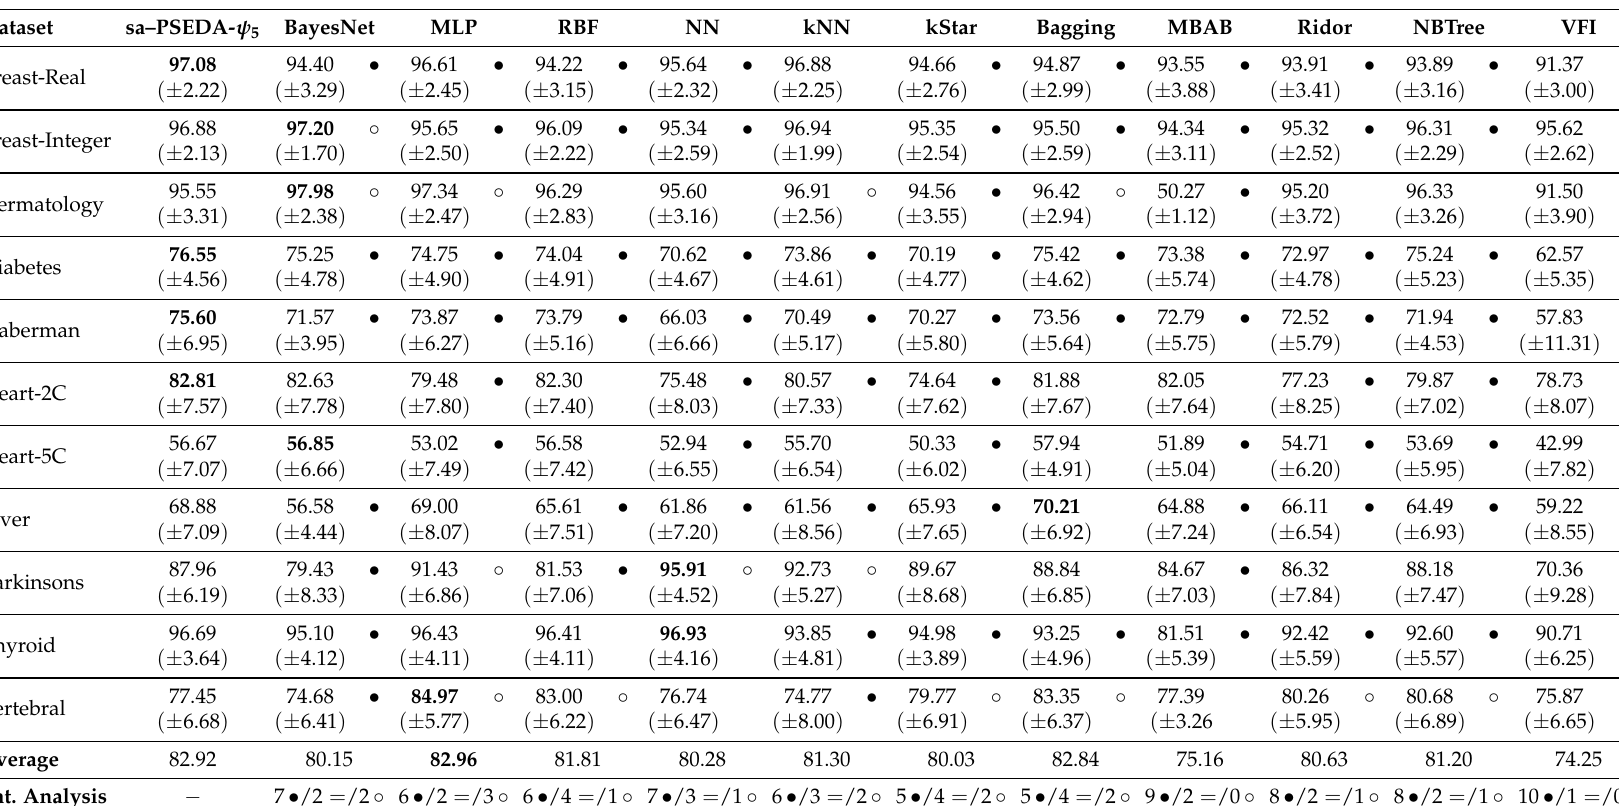
Table 6. Average accuracy ± standard deviation and statistical analysis [42] for sa-PSEDA- ψ 5 against state-of-the-art algorithms from Reference [42] over the 11 classification